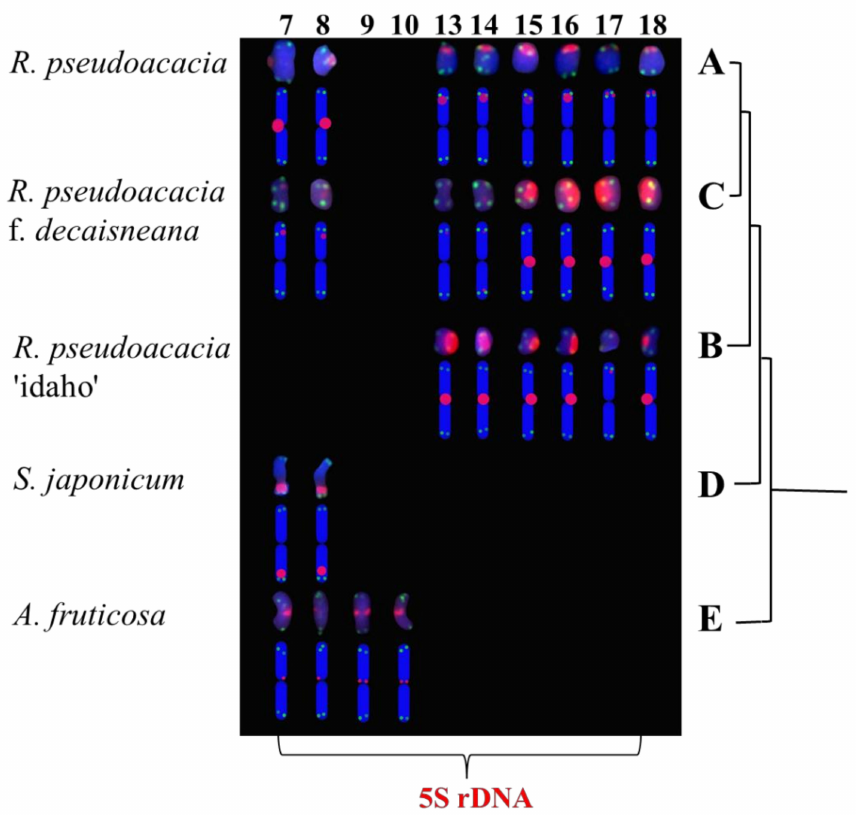
Figure 5. Physical map of Fabaceae. ( A ) R. pseudoacacia , ( B ) R. pseudoacacia ‘idaho’, ( C ) R. pseudoacacia f. decaisneana . ( D ) S. japonicum , and ( E ) A. fruticose . Signal pattern ideographs were constructed based on the signal patterns of the chromosomes mentioned above and the chromosomes in Figure 4. The numbers at the top represent the number of chromosomes, and the 5S rDNA signal type at the bottom were consistent with the five Fabaceae in Figure 4. The blue solid or dotted lines on the right were clustered according to the genetic relationship of 5S